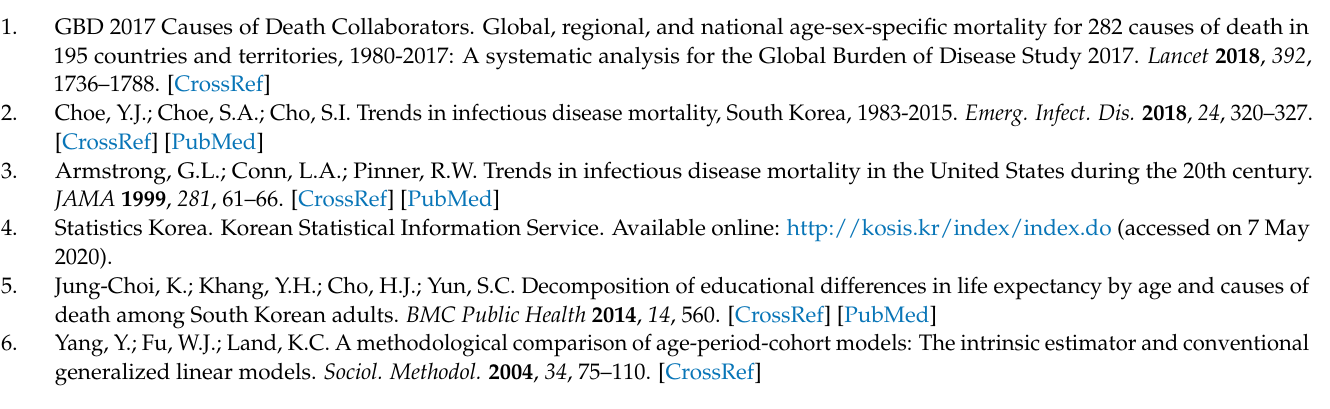
components. Table S2: Age-standardized mortality rates from infectious diseases by sex and age group in South Korea from 1983 to 2017. Table S3: Rate ratios based on intrinsic estimator coefficients for age, period, and cohort for infectious disease deaths in South Korea from 1983 to